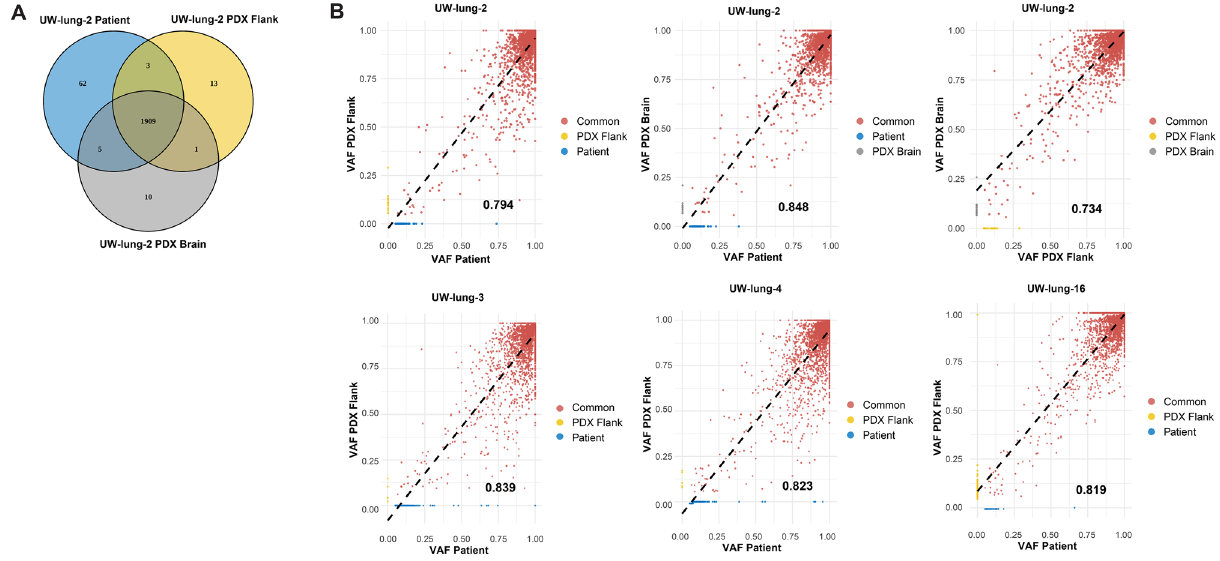
Figure 5. Conservation of patient-derived xenografts (PDXs) mutational landscape. ( A ) Venn diagram of all variants detected in UW-lung-2 patient brain metastasis, brain PDX and flank PDX. ( B ) Scatterplots displaying the correlation between patient brain metastasis variant allele frequency (VAF) and flank PDX, patient brain metastasis VAF and brain PDX and flank PDX and brain PDX. The R 2 value is represented by the black value in the lower right-hand corner of each